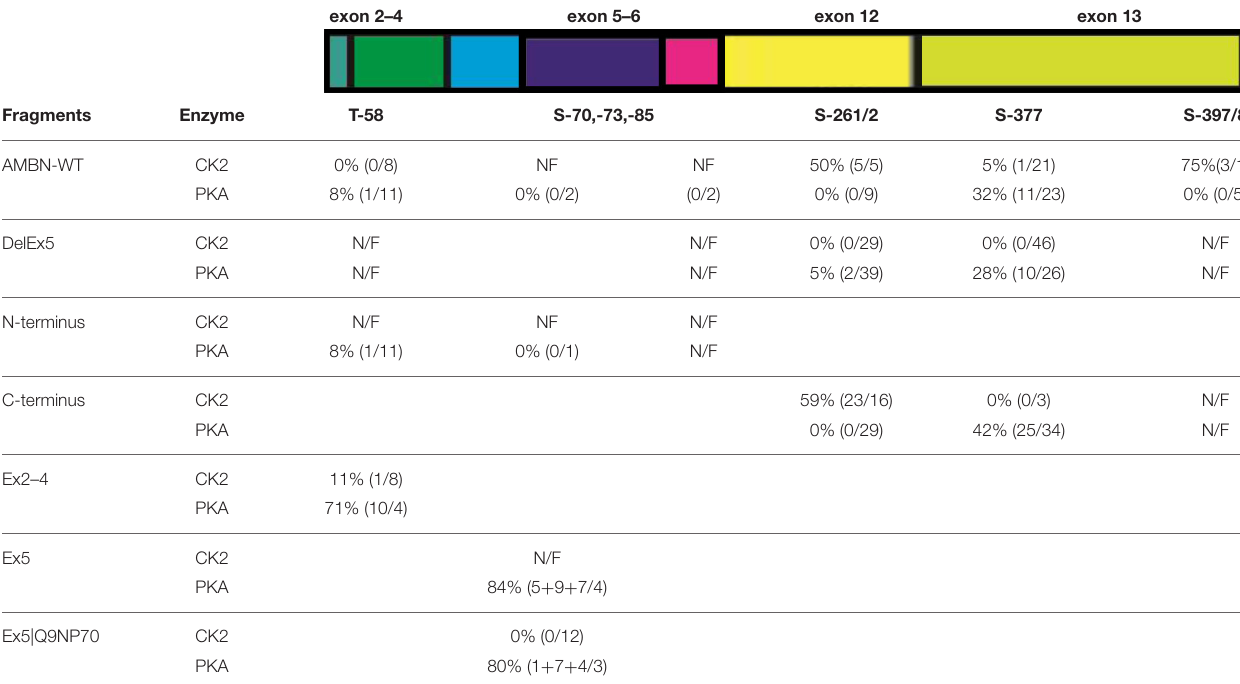
TABLE 1 | Ratio of phosphorylated residues of AMBN.